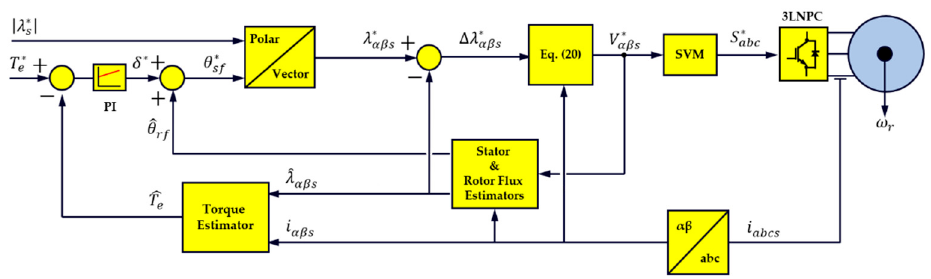
Figure 13. Direct-Torque Control Space-Vector Modulation (DTC-SVM) block diagram.